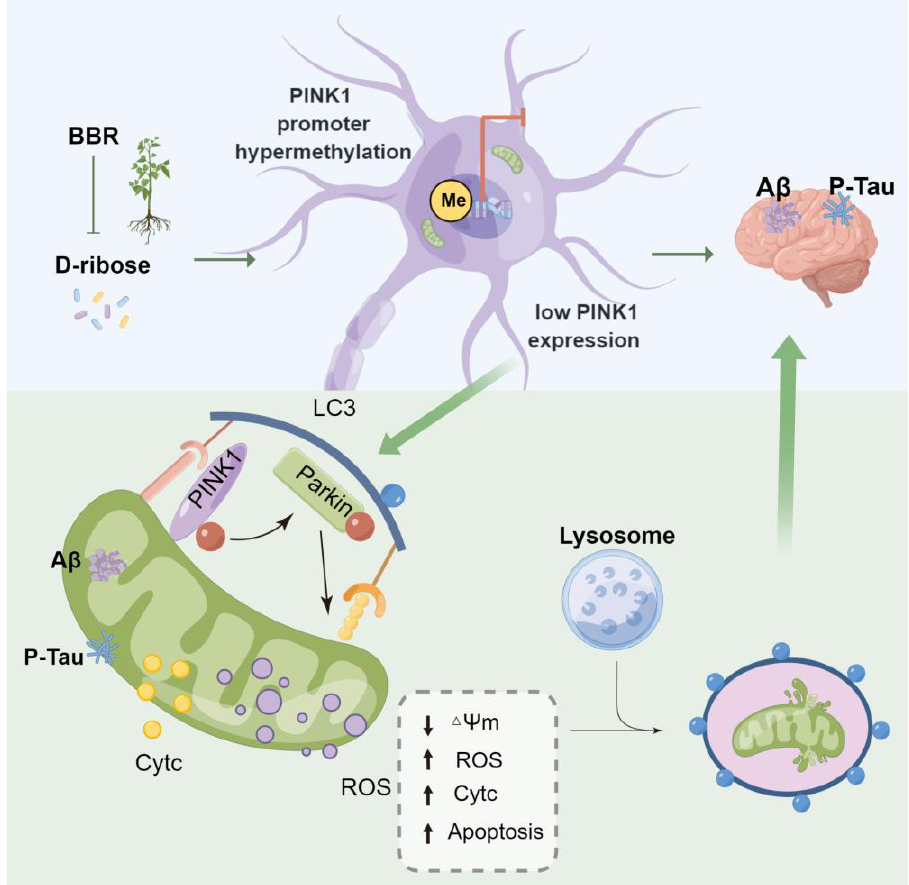
Figure 8. Hypothesis: proposed mechanism of BBR repairing D-ribose-induced Alzheimer‘s pathol- ogy. D-ribose induced mitochondrial dysfunction and damaged mitophagy including mitochondrial membrane potential decreased, ROS and Cytc release increased, cell apoptosis. However, BBR can reverse the above effects of D-ribose, improve mitochondrial function and restore mitophagy through the PINK1–Parkin pathway, so as to alleviate cognitive impairment and pathology induced by D-ribose, which is related to inhibition of PINK1 promoter